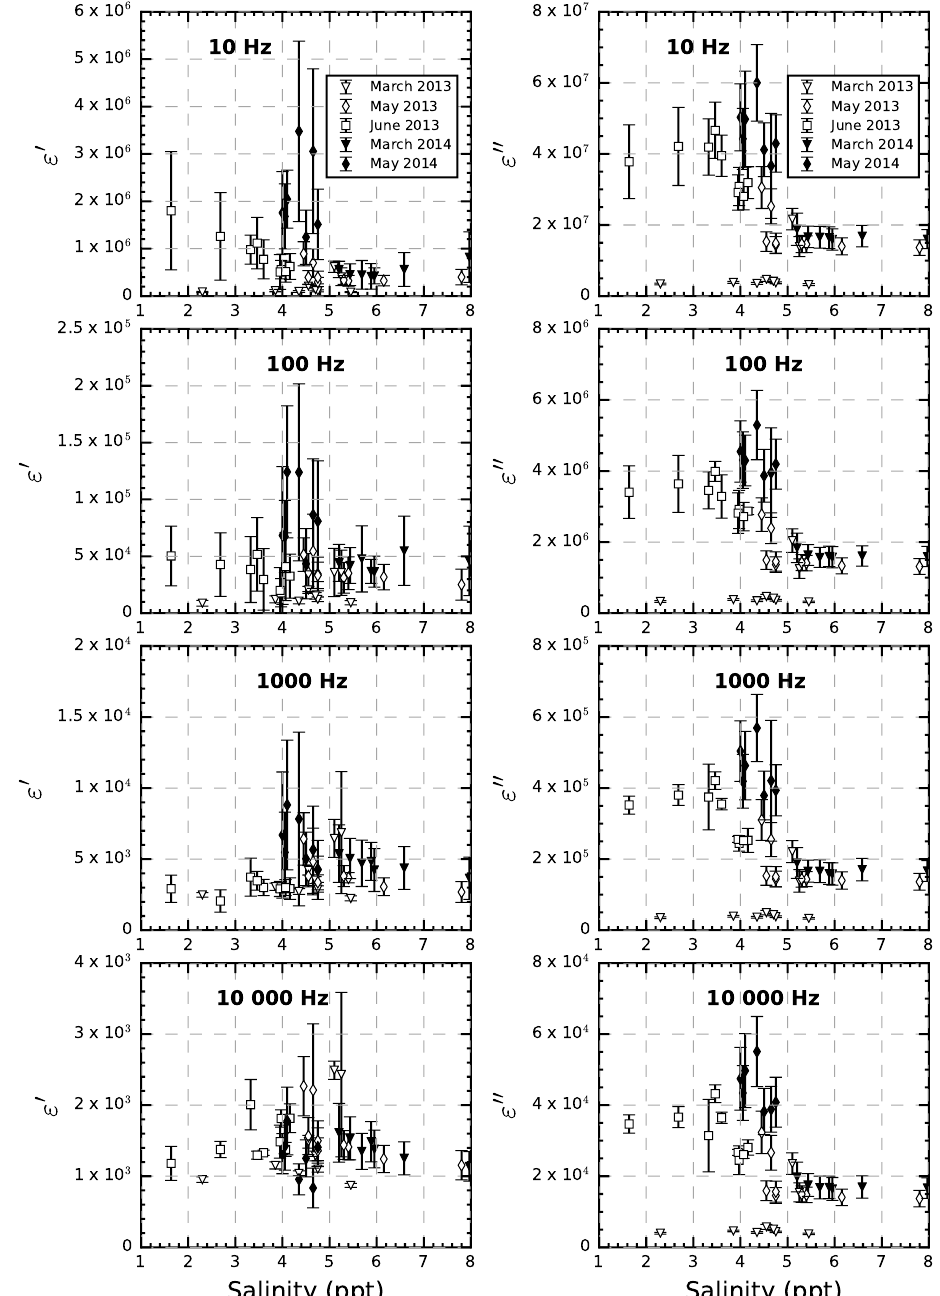
Figure 7. Variation of the real ( ε (cid:48) ) and imaginary ( ε (cid:48)(cid:48) ) parts of the measured permittivity as a function of bulk ice salinity. Triangles: late March; diamonds: mid-May; squares: early June; open symbols: 2013; filled symbols: 2014.